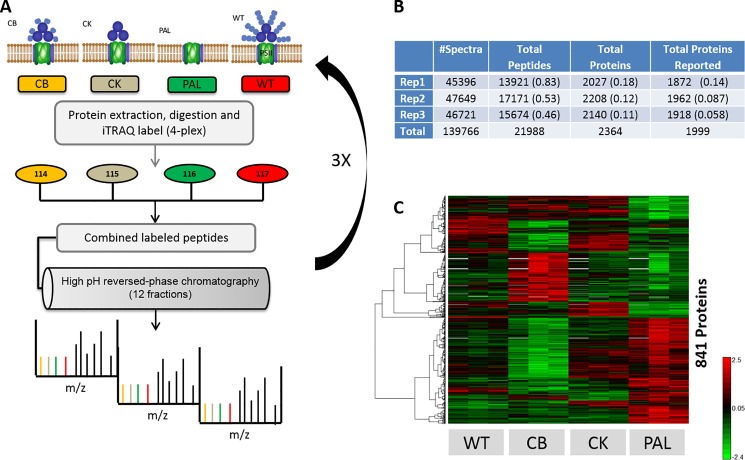
Overview of proteomic analysis and initial results.A) Schematic design of iTRAQ based quantitative LC-MS/MS experiment for comparison of each PBS mutant against WT. Triplicate biological replicates, iTRAQ experiments, were performed based upon off-line high pH reversed phase peptide level separations prior to LC-MS/MS analysis of each fraction. B) Table providing total peptide and protein level identification after data processing using MSGF+. Numbers in parenthesis represents % standard deviation of results across channels per biological replicate. C) Heat map of proteins after ANOVA statistical comparison (pval <0.01) for all conditions, demonstrating biological replicate consistency and extensive differential protein abundances across PB mutants.